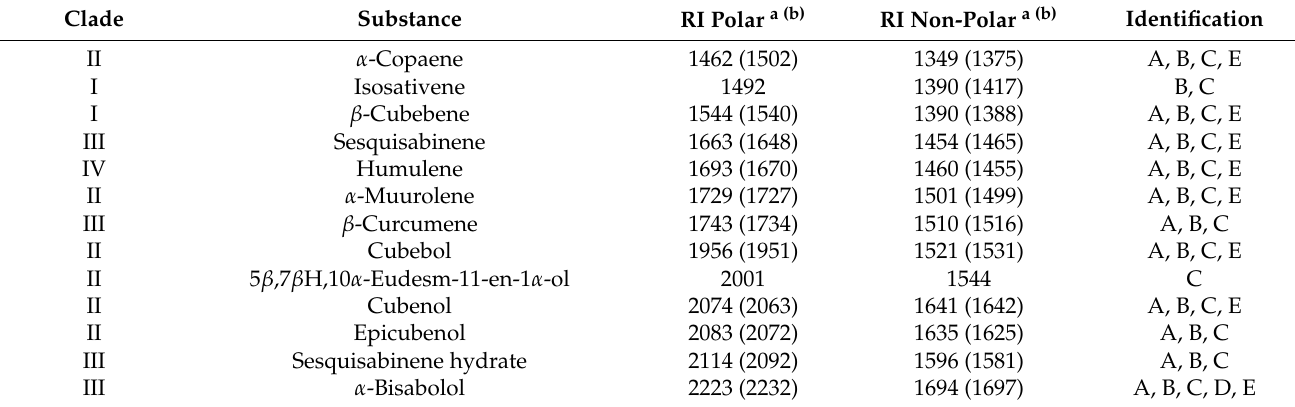
Table 1. Volatile sesquiterpenoids produced by Cerrena unicolor